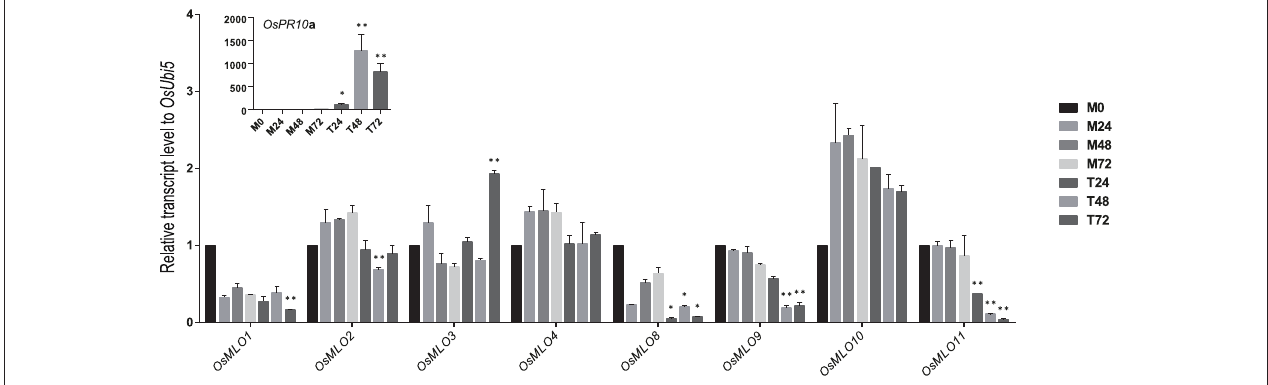
FIGURE 9 | Real-time analysis of OsMLO genes in Dongjin rice variety inoculated with M. oryzae PO6-6. Samples from mock treatment (M), and fungal inoculation treatment (T) were examined after inoculation for 24, 48, and 72 h. Numbers after C and R indicate time points (hours) after stress or MOCK treatment.